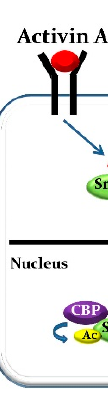
Figure 1. Activation of activin A signaling stimulates Smad2 acetylation. Smad2 is strongly acetylated by activin A stimulation in M-BMMs because CBP is localized only in nucleus and its association with Smad2 increases upon nuclear accumulation of Smad2 as a result of activin A treatment.